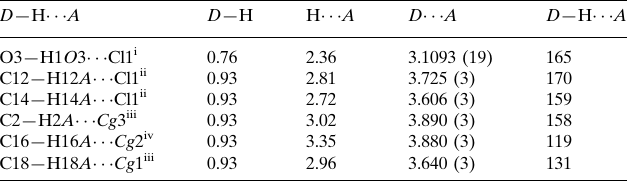
Hydrogen-bond geometry (A˚ , (cid:1)